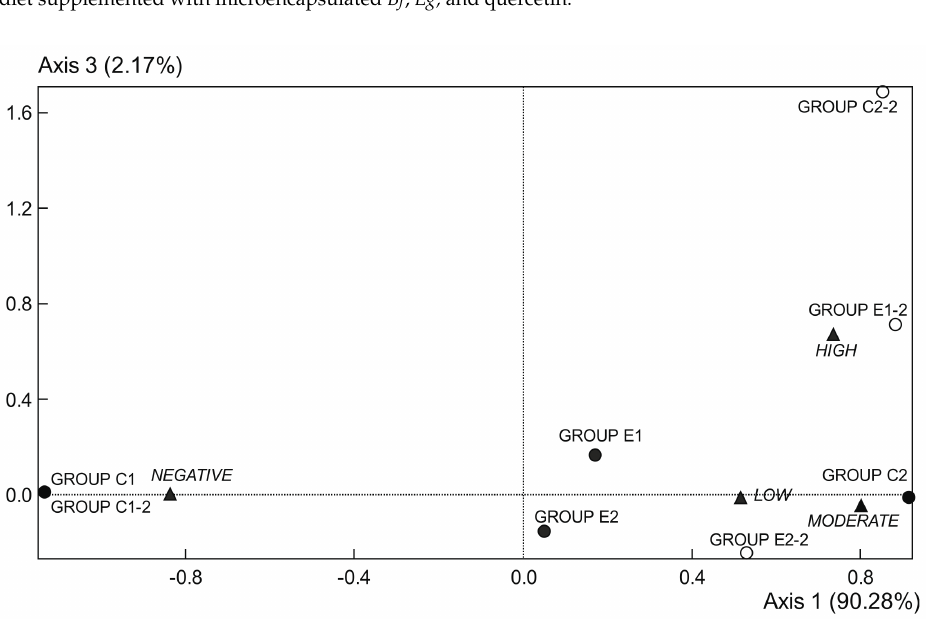
Data collected for 6 cages per group and 3 replicates per cage. Staining intensity: 0 zero intense, 1 slightly intense, 2 moderate intense, and 3 very intense. C1 wild-type mice fed a standard diet, C2 Apc Min/+ fed a standard diet,